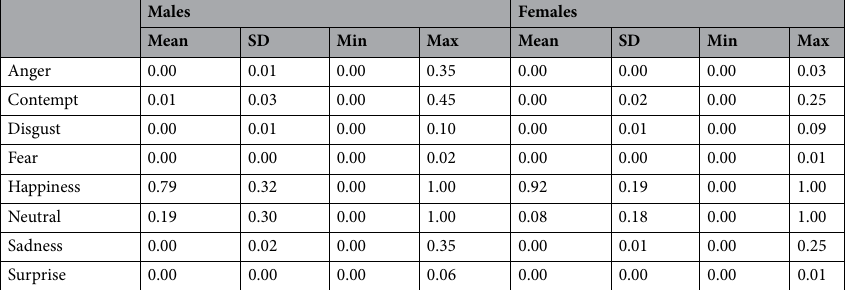
Table 1. Descriptive statistics for facial expressions. The scores are based on the training samples since this is the largest sample and represents what the model has “learned.” Each face is identified as representing a given expression to a given degree. Thus, a given face could be scored as primarily similar to happiness (0.65), but also similar to a neutral expression (0.35).